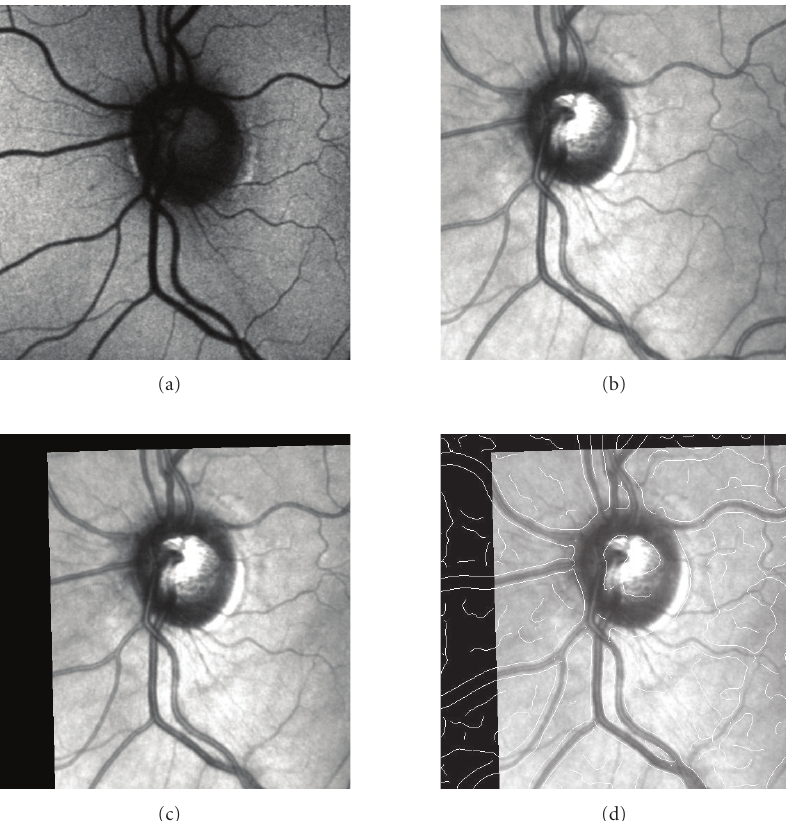
Figure 6: AF-IR registration results: (a) AF image, (b) IR image, (c) registered IR image, (d) edge image for evaluation.